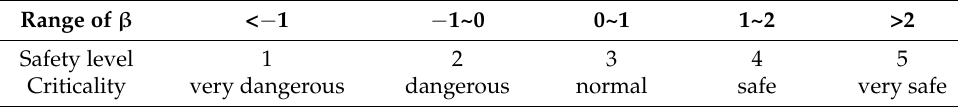
Table 7. Structure safety